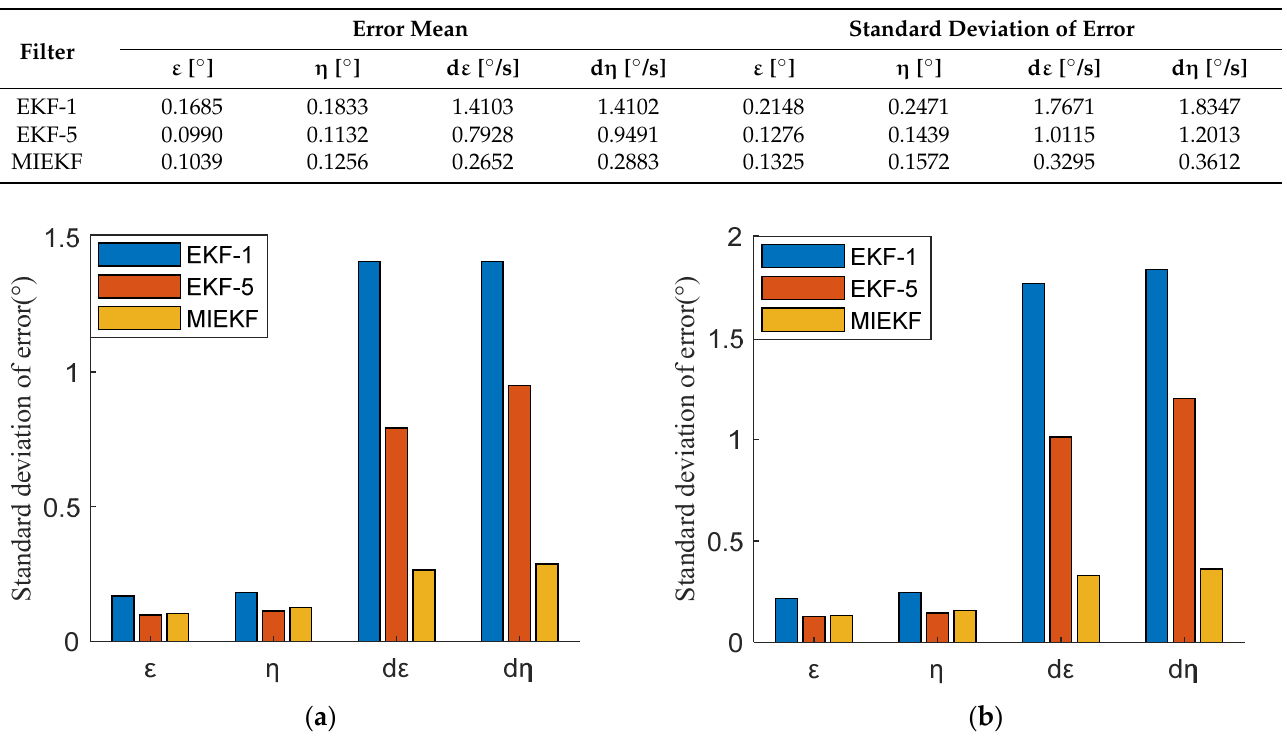
Figure 13. The error of EKF1, EKF5 and MIEKF. ( a ) The mean error. ( b ) The standard deviation. Table 3. The error means and standard deviations of error of EKF-1, EKF-5 and MIEKF.